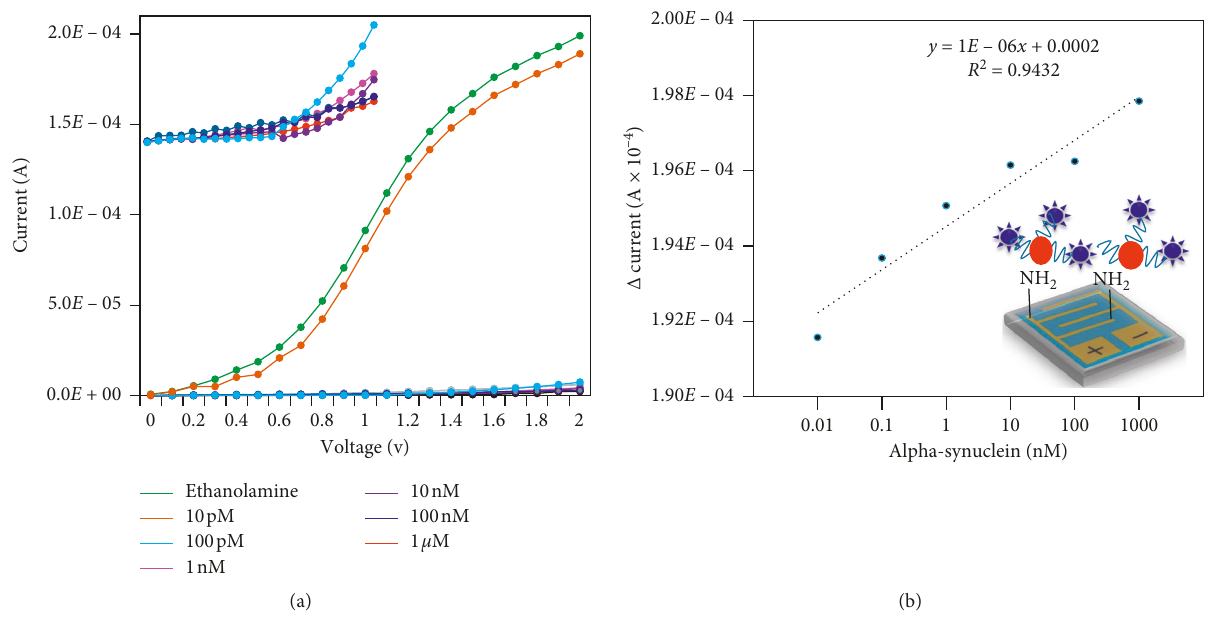
Figure 5: (a) Dose-dependent binding of alpha-synuclein on the GNP-aptamer-modified IDE sensing surface. Alpha-synuclein con- centrations from 0.1 to 1000pM were tested independently on the IDE surface. (b) Linear regression analysis with different concentrations of alpha-synuclein. The limit of detection was 10 pM. Schematic representations are shown in the figure